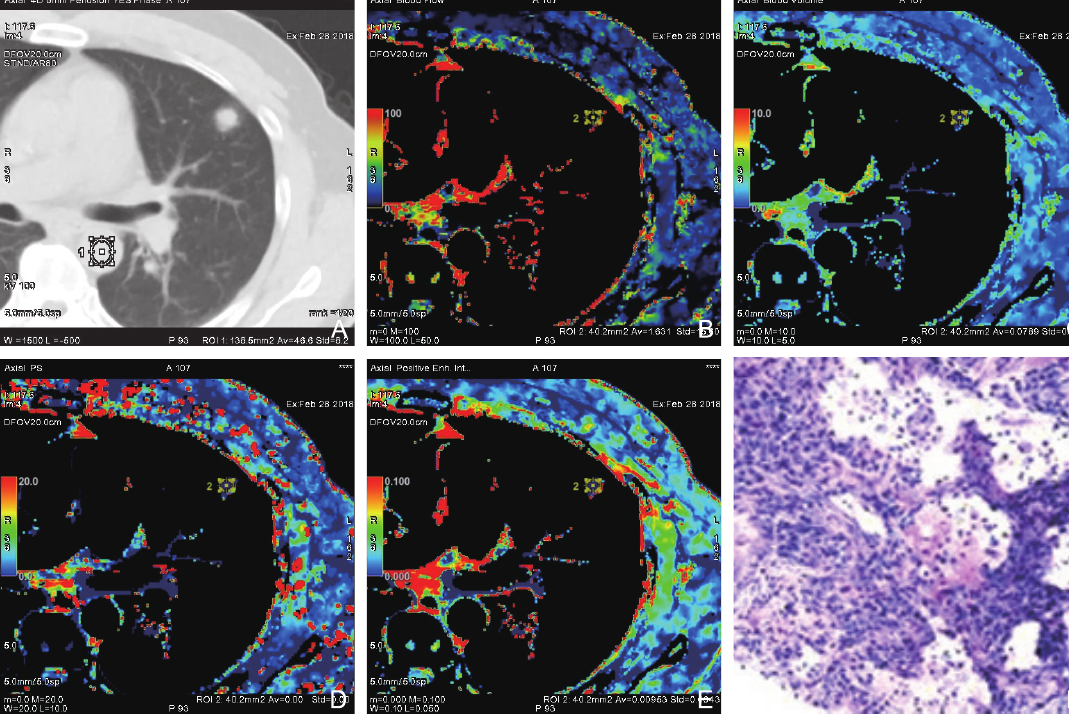
Figure 3 A 61-year-old man with pulmonary nodule. A, located in the left upper lobe. CT perfusion parameters BF (B), BV (C), PS (D) and PEI (E) in the nodule (A) of inflammatory nodule proved by pathological specimen (F). BF, BV, PS and PEI in the previous malignant nodule (Figure. 2A) were higher than the latter benign nodule (Figure. 3A)